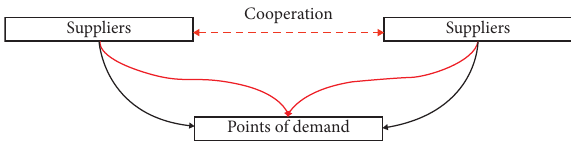
Figure 1: Graphic description of the programming model. The red line represents the consolidation of cargo from cooperation, while the black line represents an individualistic distribution